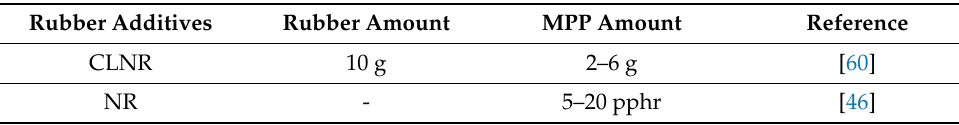
Table 10. Application of MPP in rubber